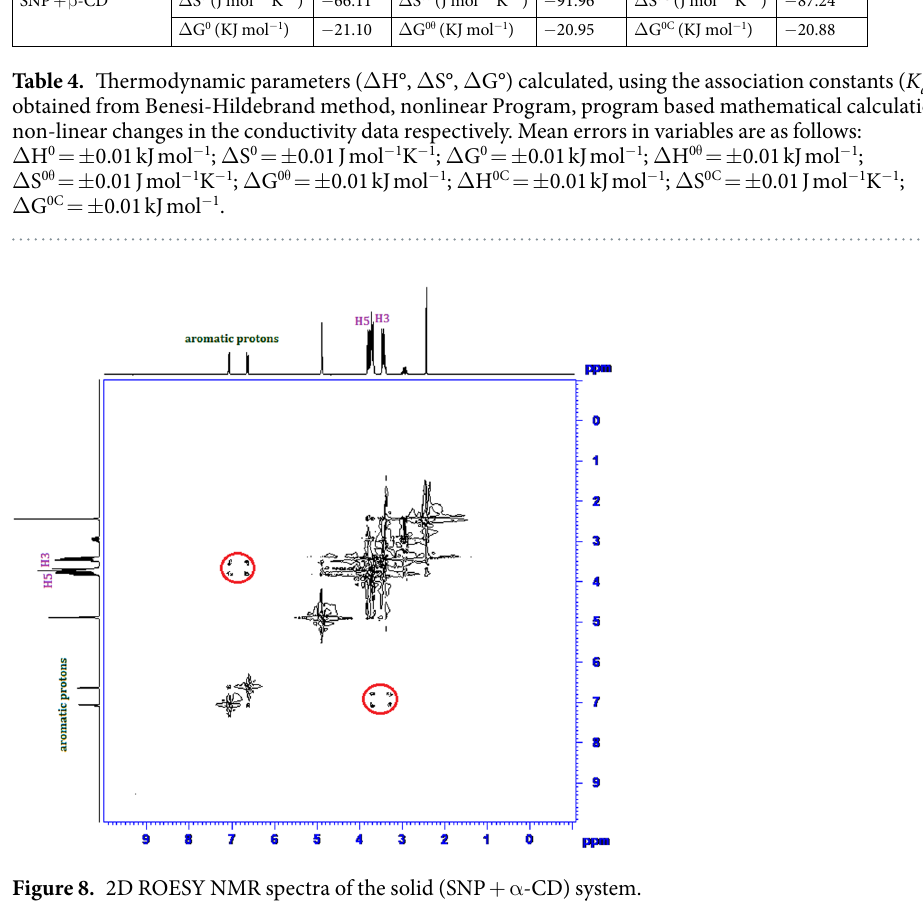
Figure 8. 2D ROESY NMR spectra of the solid (SNP + α -CD)